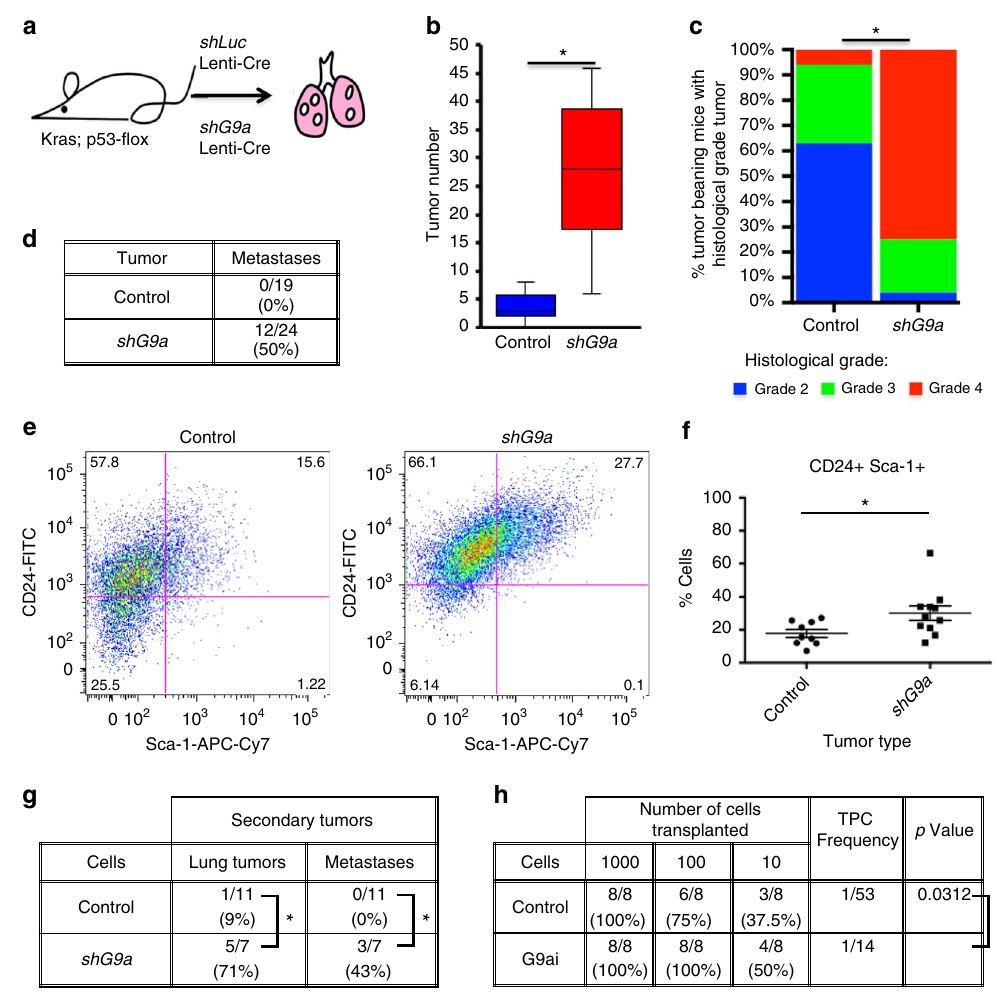
Fig. 2 G9a depletion expands the TPC population and promotes tumor progression and metastasis. a Cartoon of experimental design to deplete G9a in Cre-induced adenocarcinomas. b Box and Whisker plot of tumor number per mouse, in recipients of control and shG9a lentiviruses. Boxes represent inner quartiles, center line = median, whiskers = 1.5 × IQR. * P < 0.05, Mann – Whitney test. c Bar chart of tumor grade/mouse of control and shG9a recipients. * P < 0.05, χ 2 test, n = 16 and n = 24 mice, respectively. d Table of metastasis occurrence in the recipients of control and shG9a lentiviruses. * P < 0.05, Fisher ’ s exact test. e Representative FACS plots of dissociated tumors from control ( n = 9) and shG9a ( n = 11) recipients, gated for live, single, CD31 − , CD45 − , Epcam + cells. f Chart showing the median proportion of CD24 + Sca-1 + TPCs in control and shG9a tumors determined by FACS. Each data point represents tumors from an individual mouse. * P < 0.05, Mann – Whitney test. g Table of secondary tumor and metastasis incidence and location in recipients of orthotopically transplanted control and shG9a tumor cells. * P < 0.05, Fisher ’ s exact test. h Table of tumor incidence and TPC frequency in recipients of control or G9ai adenocarcinoma cells in limiting dilution assay. TPC frequency and P value ( χ 2 ) were calculated by ELDA